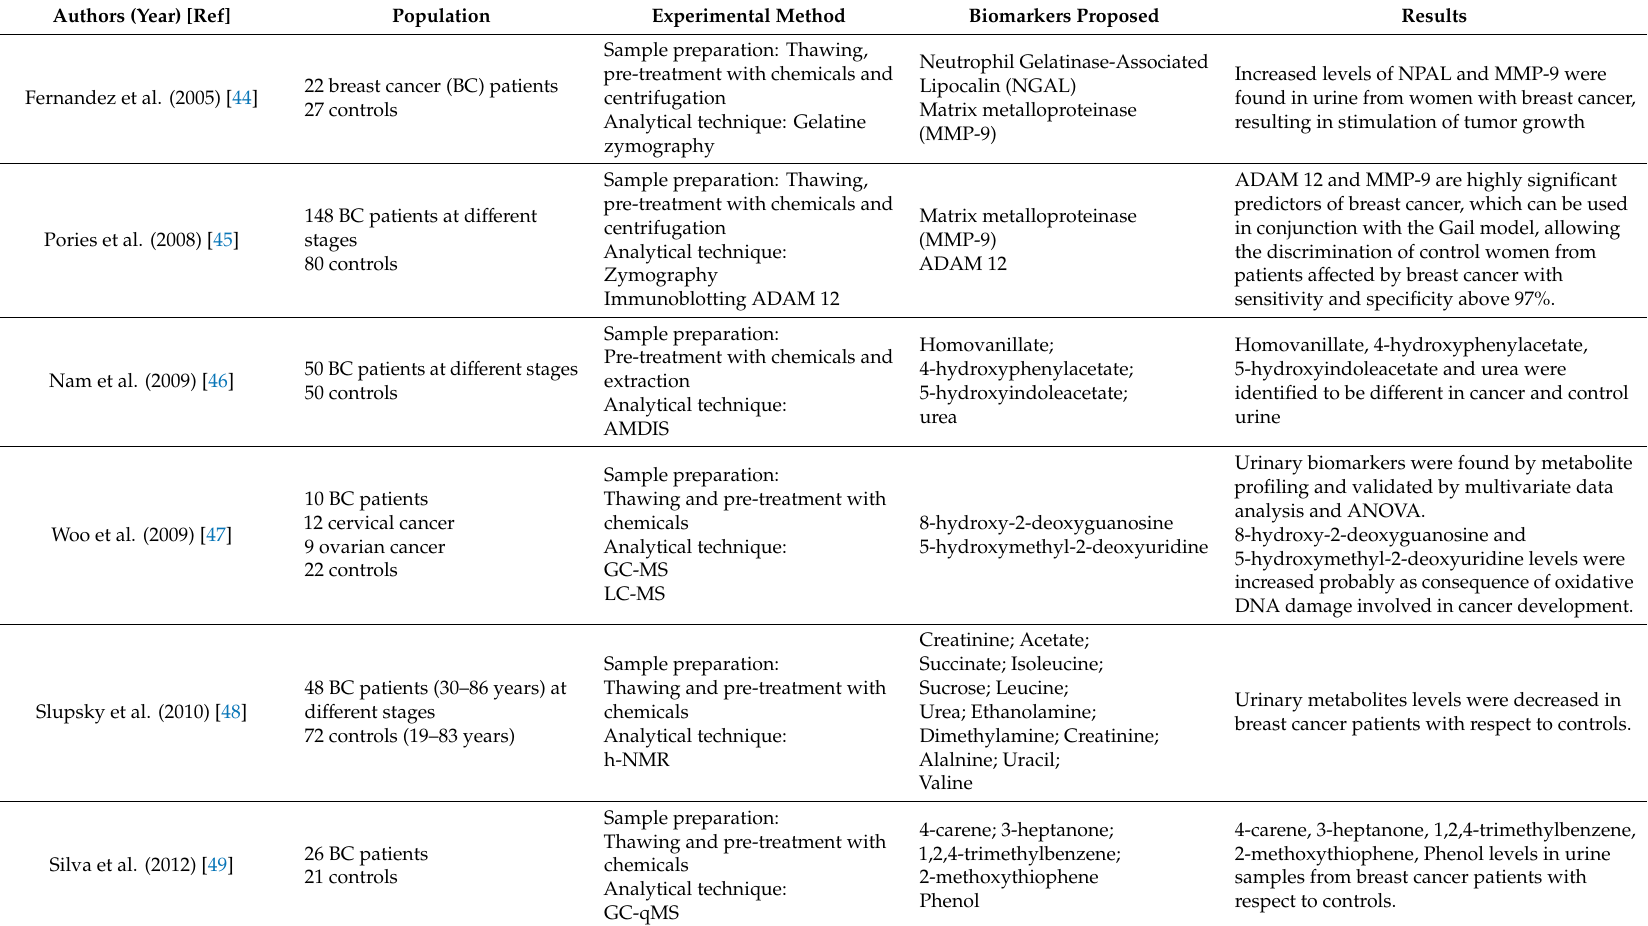
Table 2. Literary studies investigating urinary biomarkers for breast